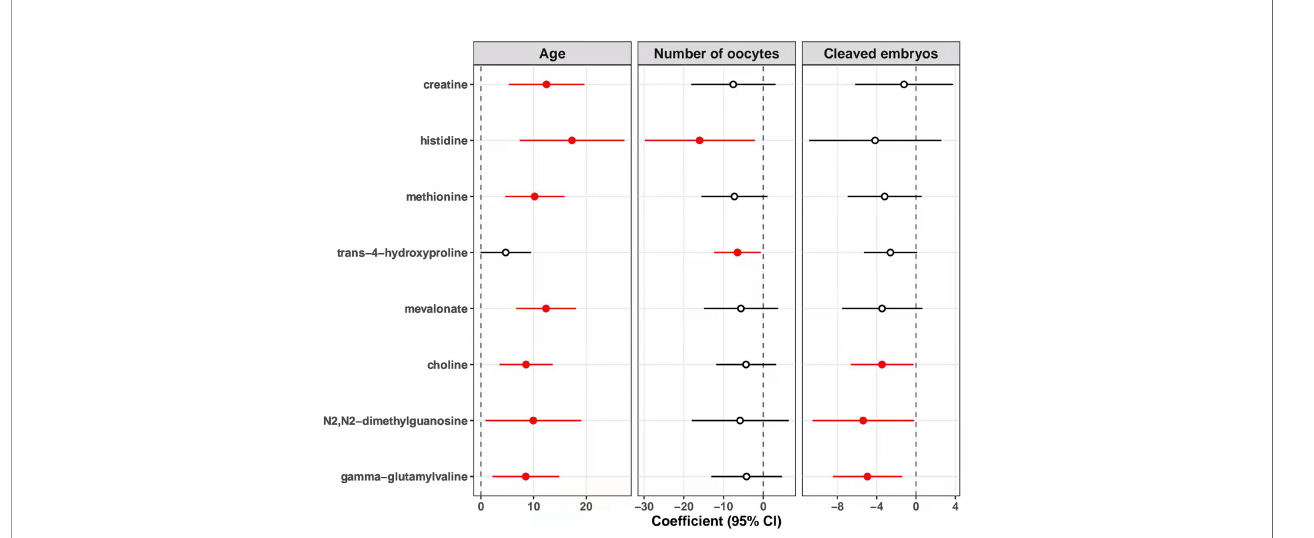
FIGURE 4 | Associations of metabolites with age, number of oocytes retrieved, and cleaved embryo numbers. The association of each identi fi ed metabolite with maternal age, number of oocytes retrieved, and number of cleaved embryos was estimated with linear regression model adjusting for the levels of basal FSH. The points and horizontal lines represent the coef fi cients and 95% con fi dence intervals (CI) of metabolites, respectively. The solid points in red mean statistically signi fi cant ( p < 0.05). FSH, follicle stimulating